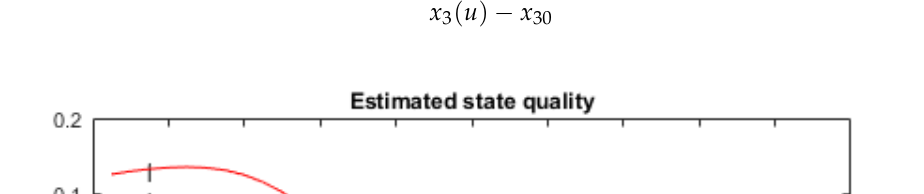
[0.15 0.75] k R  ; [0. 2.]